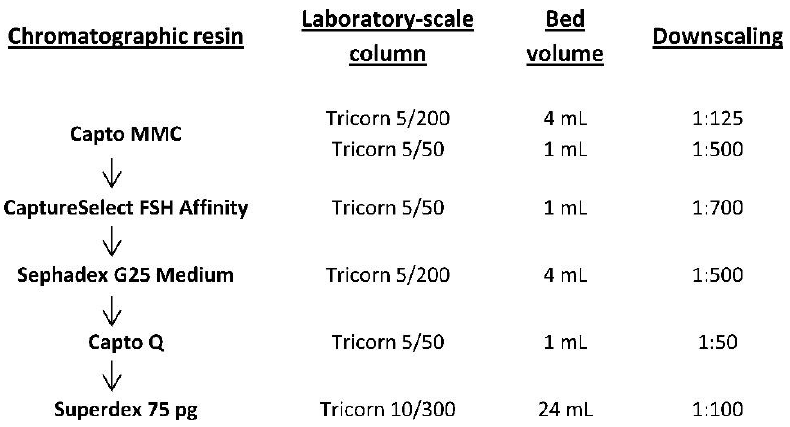
Figure 1. Overview of the downscaling of chromatographic purification steps in the production process of recombinant human follicle stimulating hormone